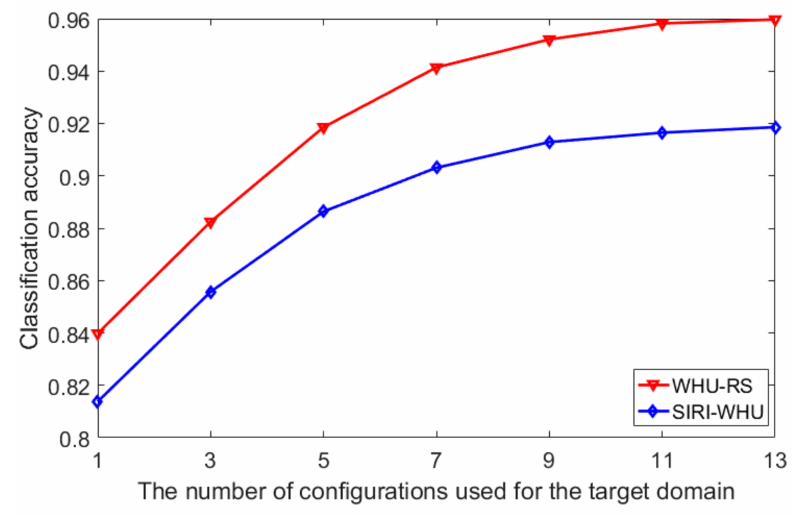
Figure 21. Effect of the number of configurations used for the target domain t on the classification accuracy in two